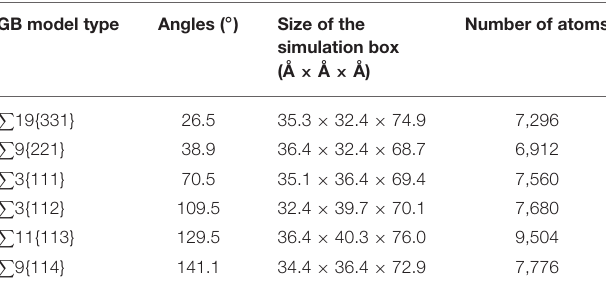
TABLE 1 | Characteristics of < 110 > STGB